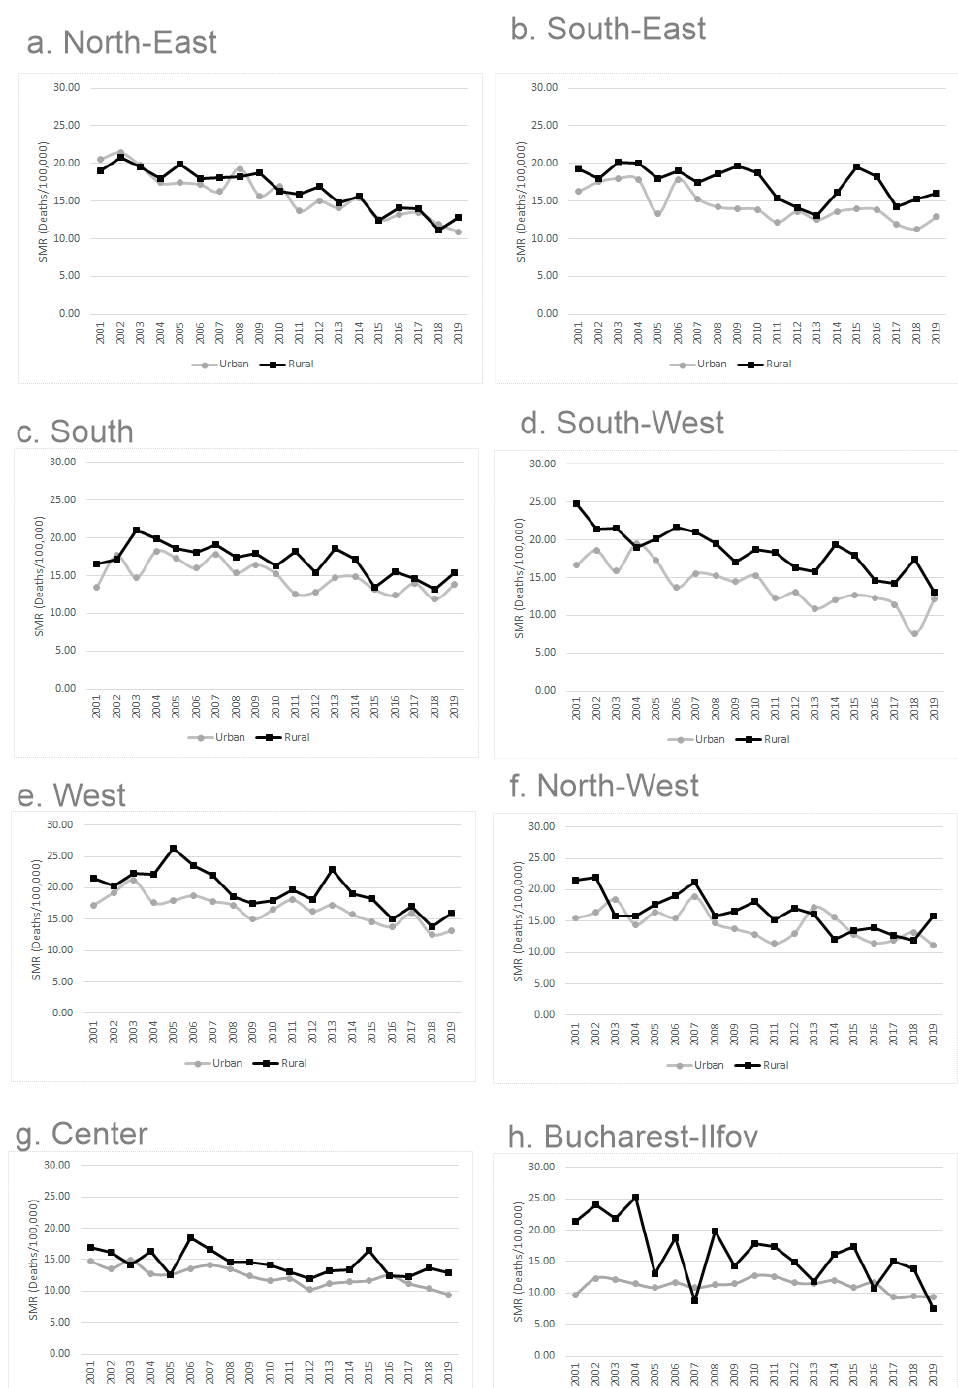
Figure 3. Regional trend in cervix cancer mortality by rural–urban areas, Romania, 2001–2019 (standardized mortality